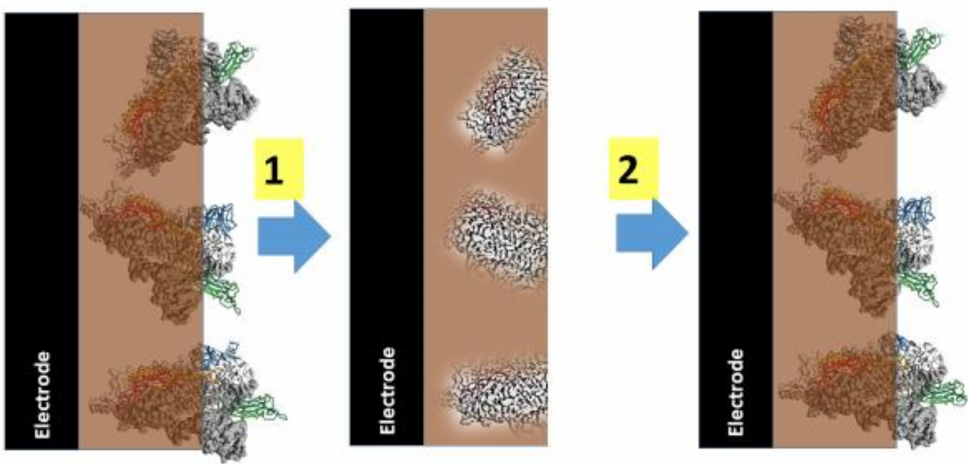
Figure 3. ( 1 ) Formation of molecularly imprinted polymer-based sensor, ( 2 ) MIP based layer in action. Figure adapted from